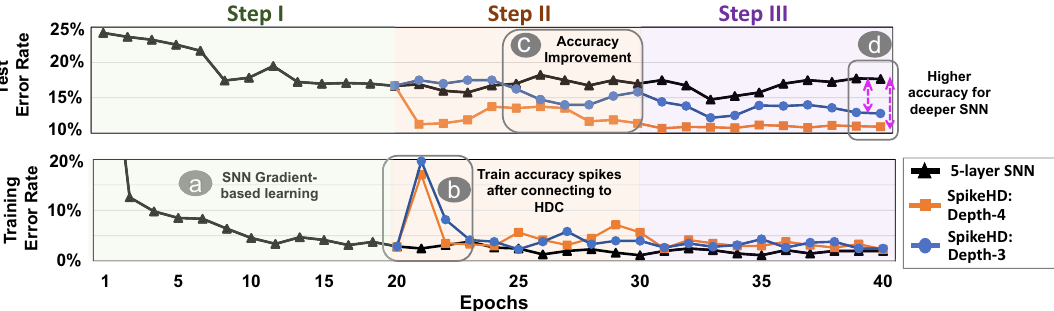
Figure 4. Average train and test accuracy of SpikeHD models with a 5-layer DECOLLE and HDC injection at various depths, compared with pure DECOLLE trained for the same number of epochs. Step 1, training SNN only, consists of 20 epochs and reaches model convergence; step 2, training HD module only, and step 3, co-training, both consist of 10 epochs, as convergence is reached earlier in general.